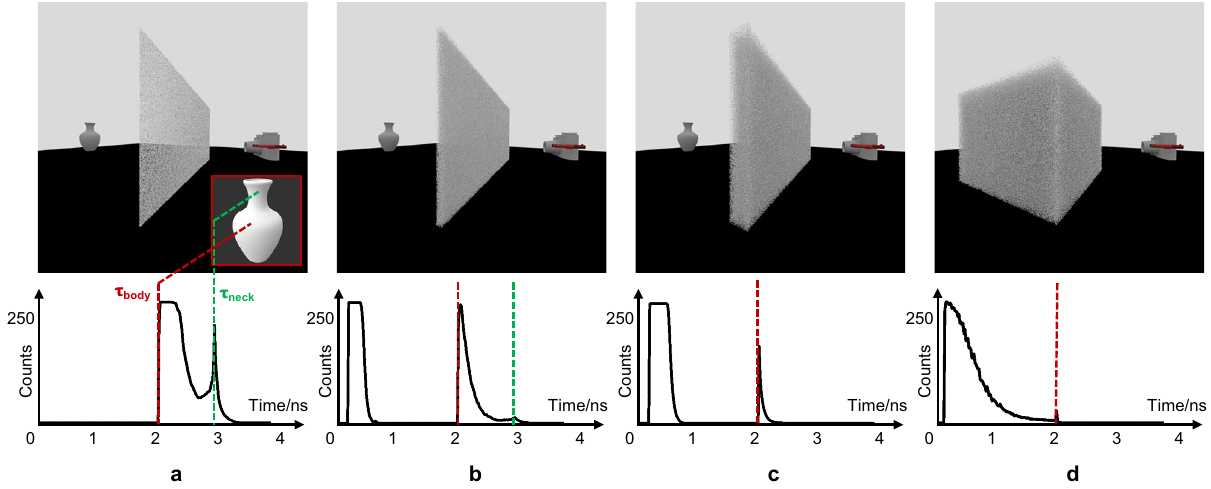
Fig. 1 Different scattering scenarios. Different columns show different scattering scenarios: imaging through scattering media with the increase of the scattering strength and the scattering region from ( a – c ) and imaging within the scattering media ( d ). The bottom row shows the synthetic temporal response under different scattering scenarios (synthetic data generation is described in Methods). According to Fermat ’ s Principle 7 , the red and green discontinuities in the transient measurements indicate that the vase surface shape is composed of a convex body and a saddle neck (details in Supplementary Note